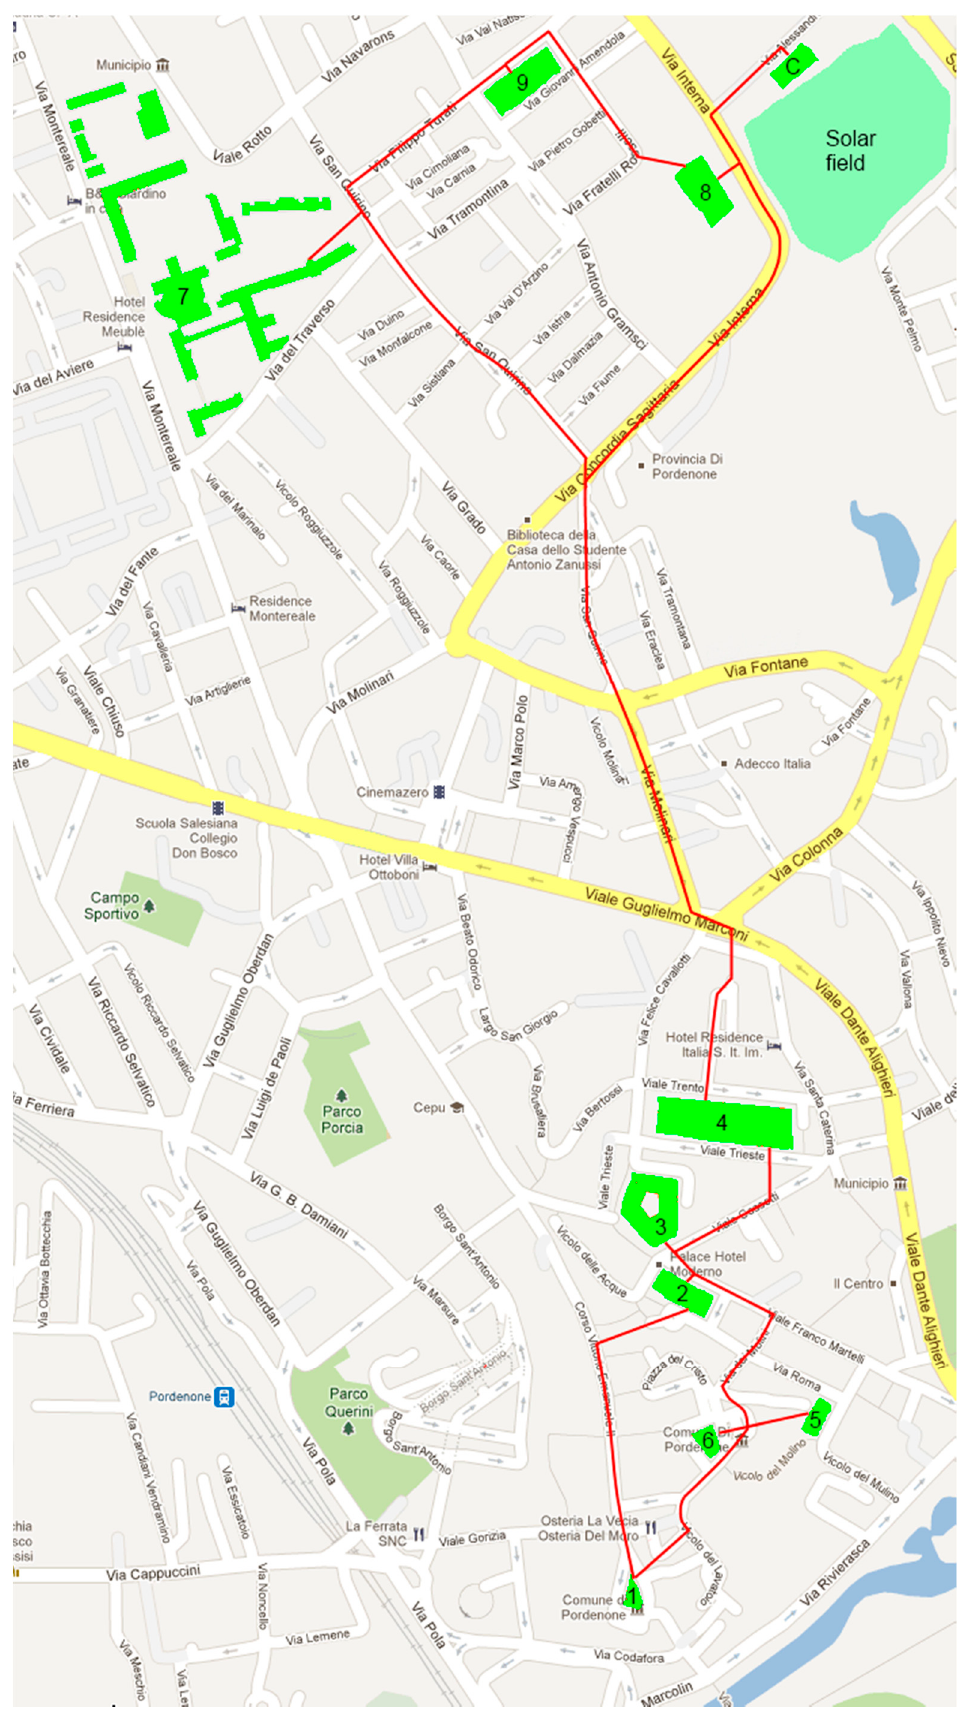
Figure 2. Plan of the possible path of the DHCN. 1—town hall; 2—theatre; 3—library; 4—primary